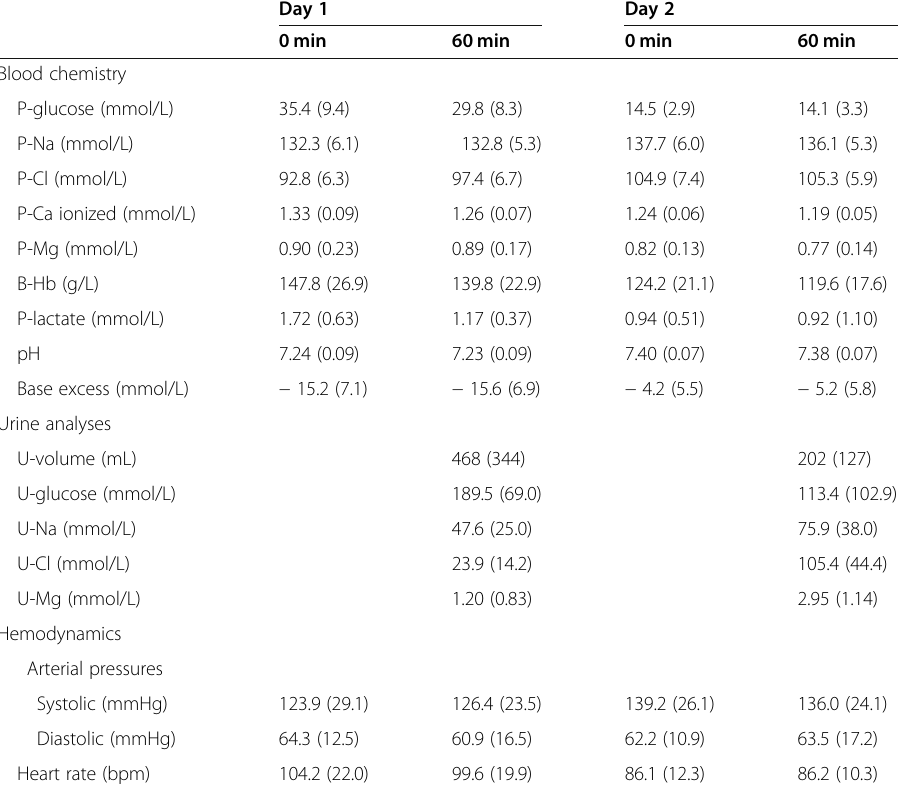
Table 1 Fluid balance variables